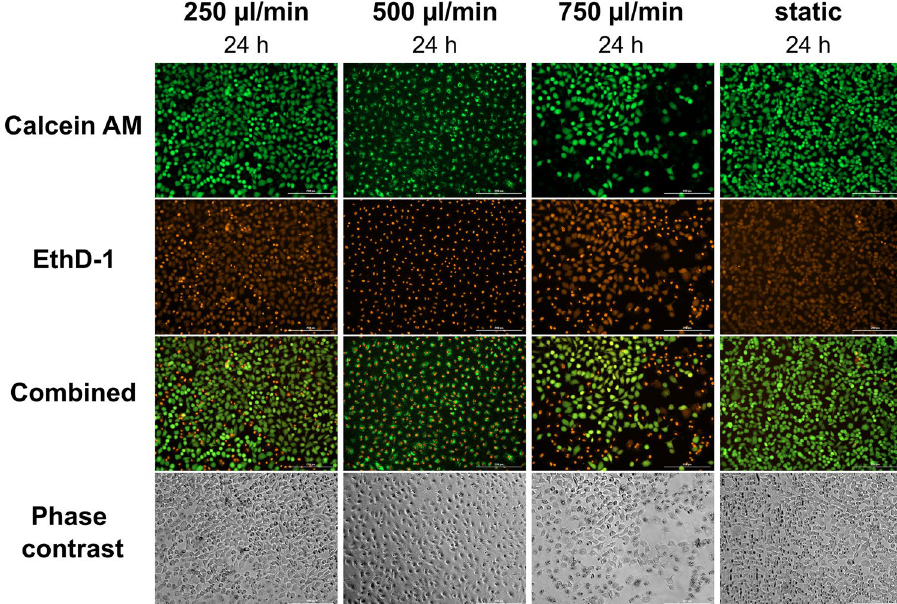
Figure 3. The viability of A549 cells under 250, 500, and 750 µl/ml flow, when the cells adhered on glass coverslips for 24 h. The cells were stained with Live/Dead viability/cytotoxicity assay. Calcein AM (green) shows alive cells and EthD-1 (ethidium homodimer-1) (orange) shows dead cells. With 500 µl/min flow rate, most of the cells seemed desiccated, which could explain the illogical decrease in viability after 2 days compared to 250 and 750 µl/min flow rates (X10, scale bar shows 200 µm).